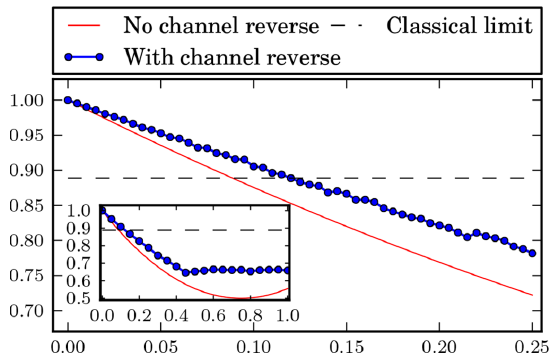
Figure 5. Amplitude damping channel. Probability of winning the pseudo-telepathy game with and without the use of our approach as a function of the noise parameter a for the amplitude damping channel. The inset shows the probability of winning for a M [0; 1].